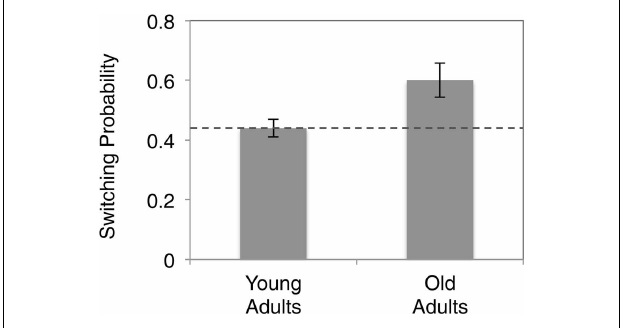
FIGURE 2 | Comparison of probabilities of “staying” across different age groups. Dashed line indicates Nash equilibrium predicted probability of repeating the same